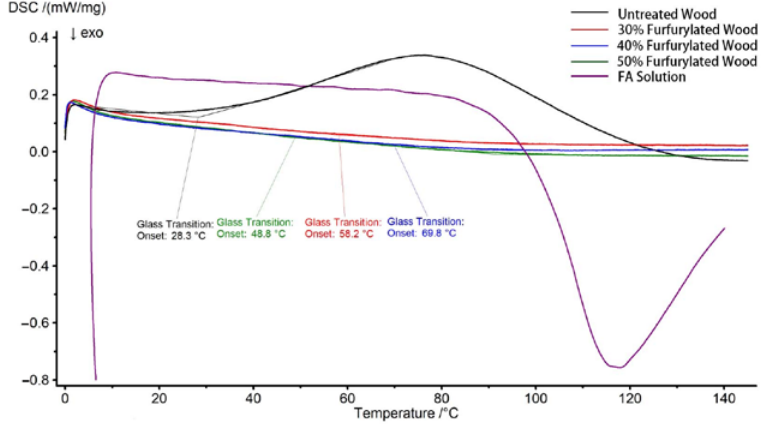
Figure 8. DSC curves of untreated and furfurylated specimens at different concentrations and FA solution. Table 2. Glass transitions at different concentrations.